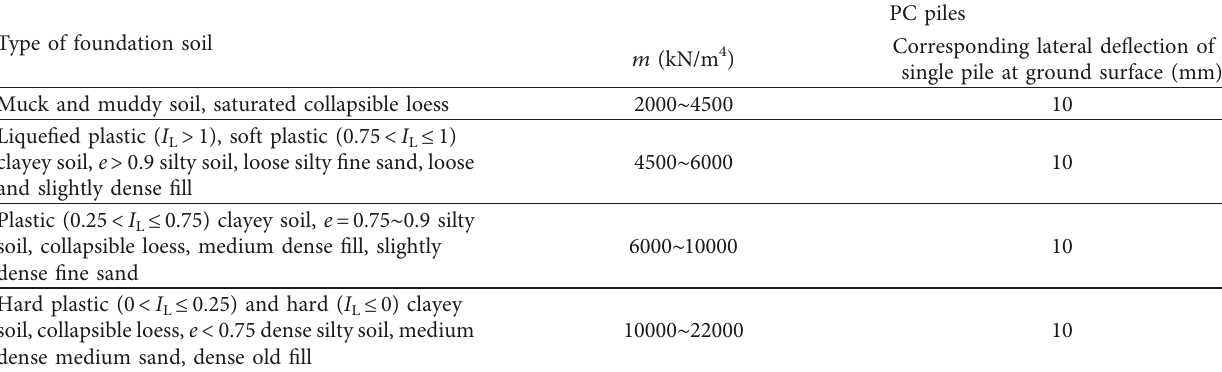
Table 3: Value of proportional coefficient m of soil lateral resistance coefficient (JGJ